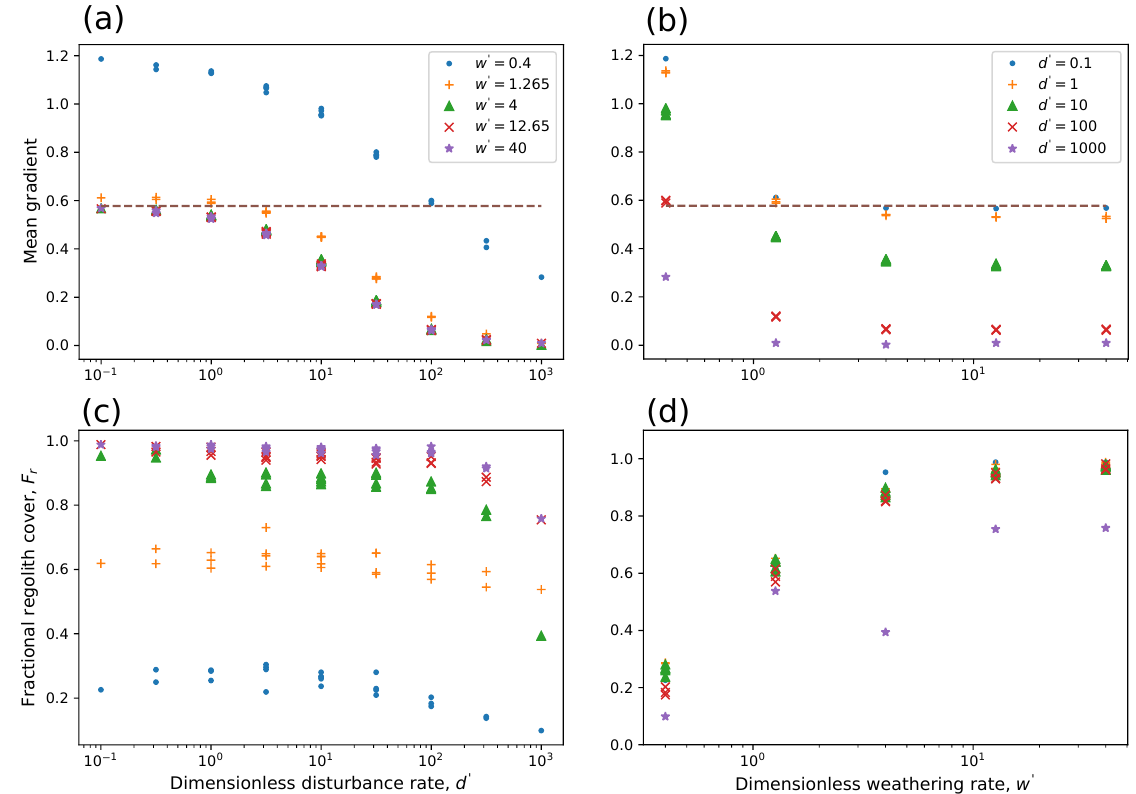
Figure 12. Mean equilibrium gradient and regolith thickness for models with rock and weathering, as a function of d (cid:48) and w (cid:48) . Data repre- sent 125 runs with d ∈ [ 10 − 3 , 10 − 2 . 5 , 10 − 2 , 10 − 1 . 5 , 10 − 1 ] yr − 1 , w (cid:48) ∈ [ 10 0 , 10 0 . 5 , 10 1 , 10 1 . 5 , 10 2 ] , and τ ∈ [ 10 2 , 10 2 . 5 , 10 3 , 10 3 . 5 , 10 4 ] yr. Horizontal dashed lines show model’s angle of repose for